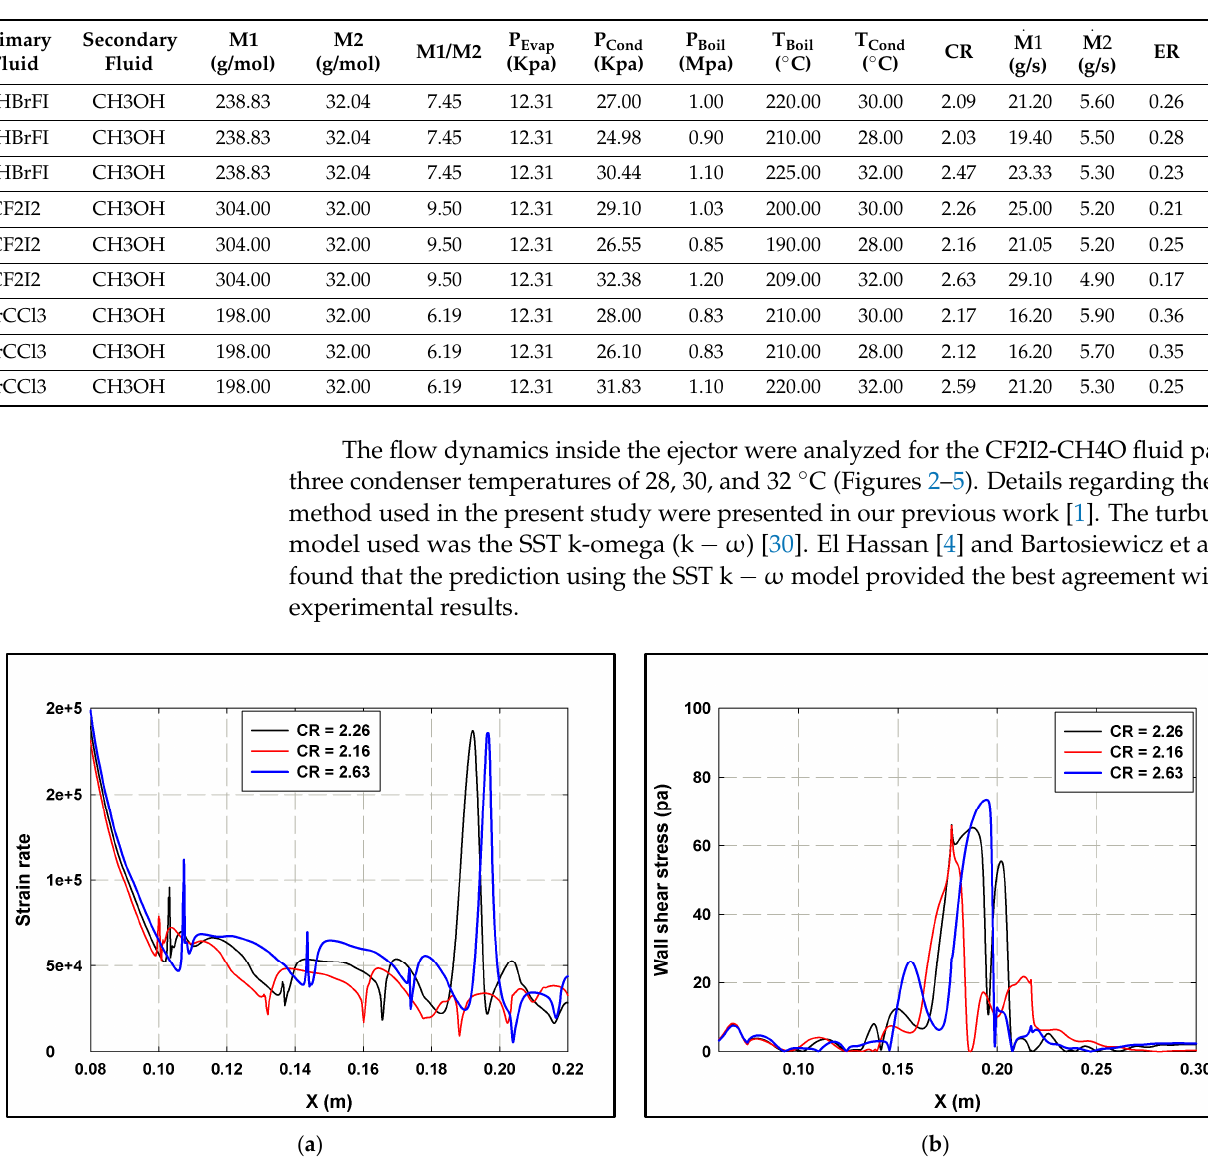
Table 5. Influence of the condenser temperature on the entrainment ratio (T Evap = 19 ◦ C) and COP.